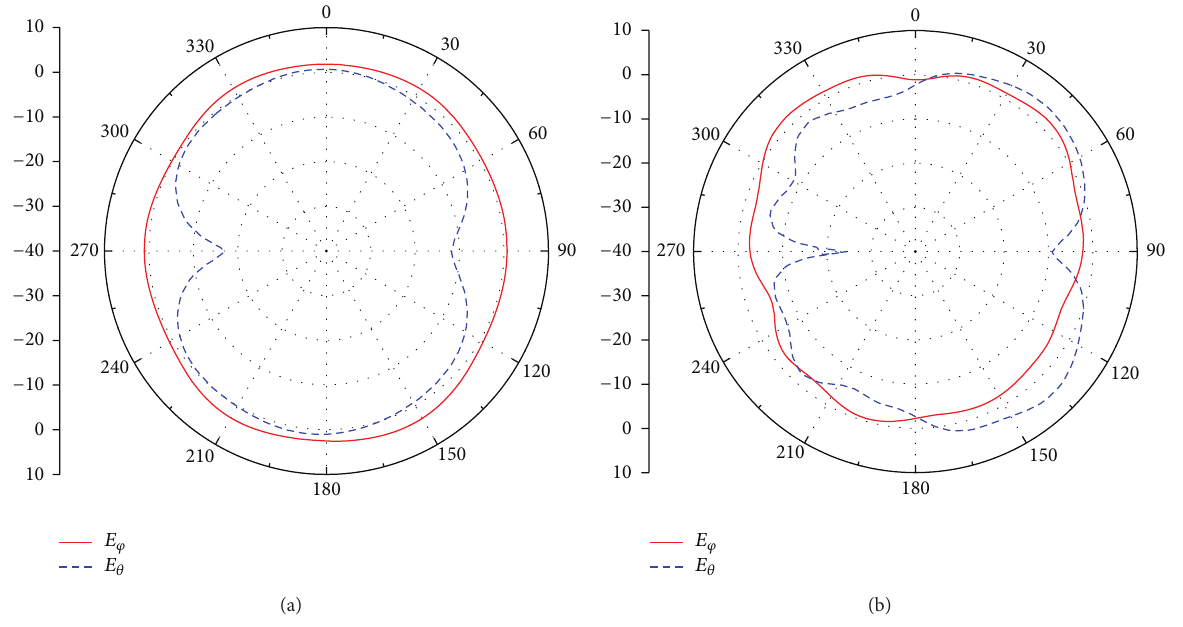
Figure 5: Simulated radiation patterns of the UWB antenna without EBGs in 𝑥𝑧 -plane at (a) 4 GHz and (b) 9 GHz.